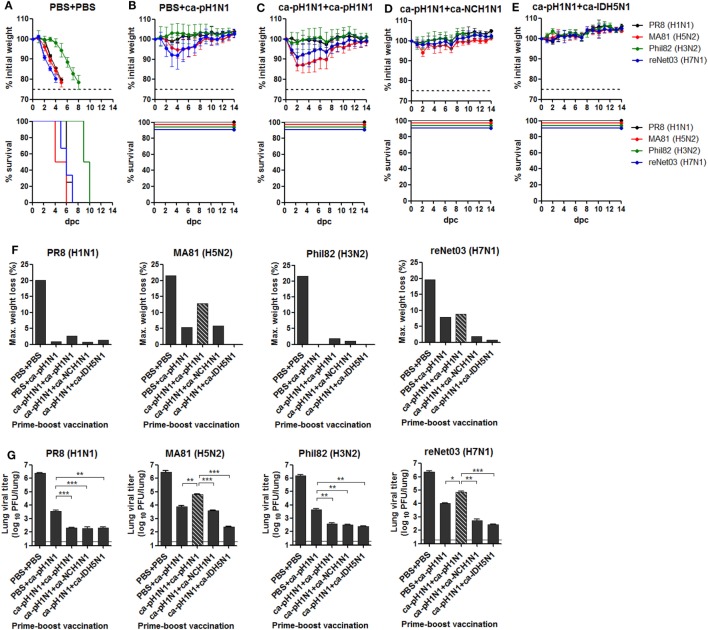
Cross-protection against lethal challenge in vivo. (A−E) Protection against lethal challenge with heterologous influenza viruses. Control mice that were given PBS (A) and vaccinated mice (N = 4) (B−E) were challenged with 10 mouse lethal dose 50 (MLD50) of each of four heterologous influenza viruses and their weight changes (upper) and survival rates (lower) were monitored daily. (F) Maximum weight loss of the challenged mice in (A) to (E). (G) Sterile immunity in the mouse lungs. Separate groups of mice (N = 5) vaccinated or given PBS were challenged with 10 MLD50 of each heterologous influenza virus. At 6 days post-challenge (dpc), the mice were sacrificed and the lungs were harvested for viral titration by plaque assay. Dashed bars indicate the data of homologous boosting vaccination (ca-pH1N1 + ca-pH1N1) that demonstrated decreased protective efficacy compared to the single vaccination, in terms of maximum weight loss and the lung viral titers. Data are the mean of each cohort, and error bars indicate SD. ***P < 0.001; **P < 0.01; *P < 0.05 when comparing the viral titers between two different groups.